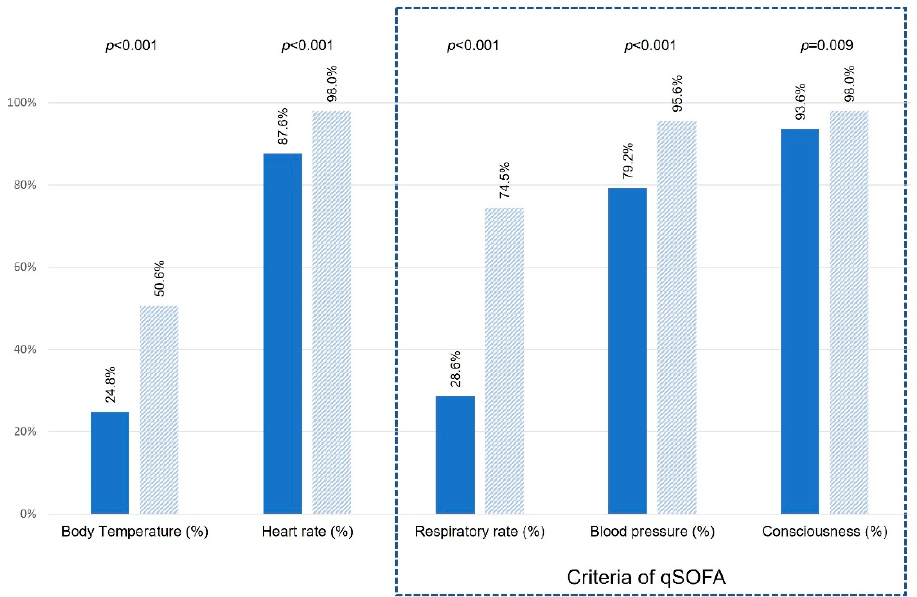
Figure 2. Frequency (%) of prehospital recorded sepsis indicators (standard assessment) and qSOFA parameters subdivided in two groups: EMS paramedics only (dark blue) and EMS with emergency physicians (light blue), p -values were calculated between both groups using Fisher’s exact tests; qSOFA parameters are highlighted in a box (right, blue grid lines).